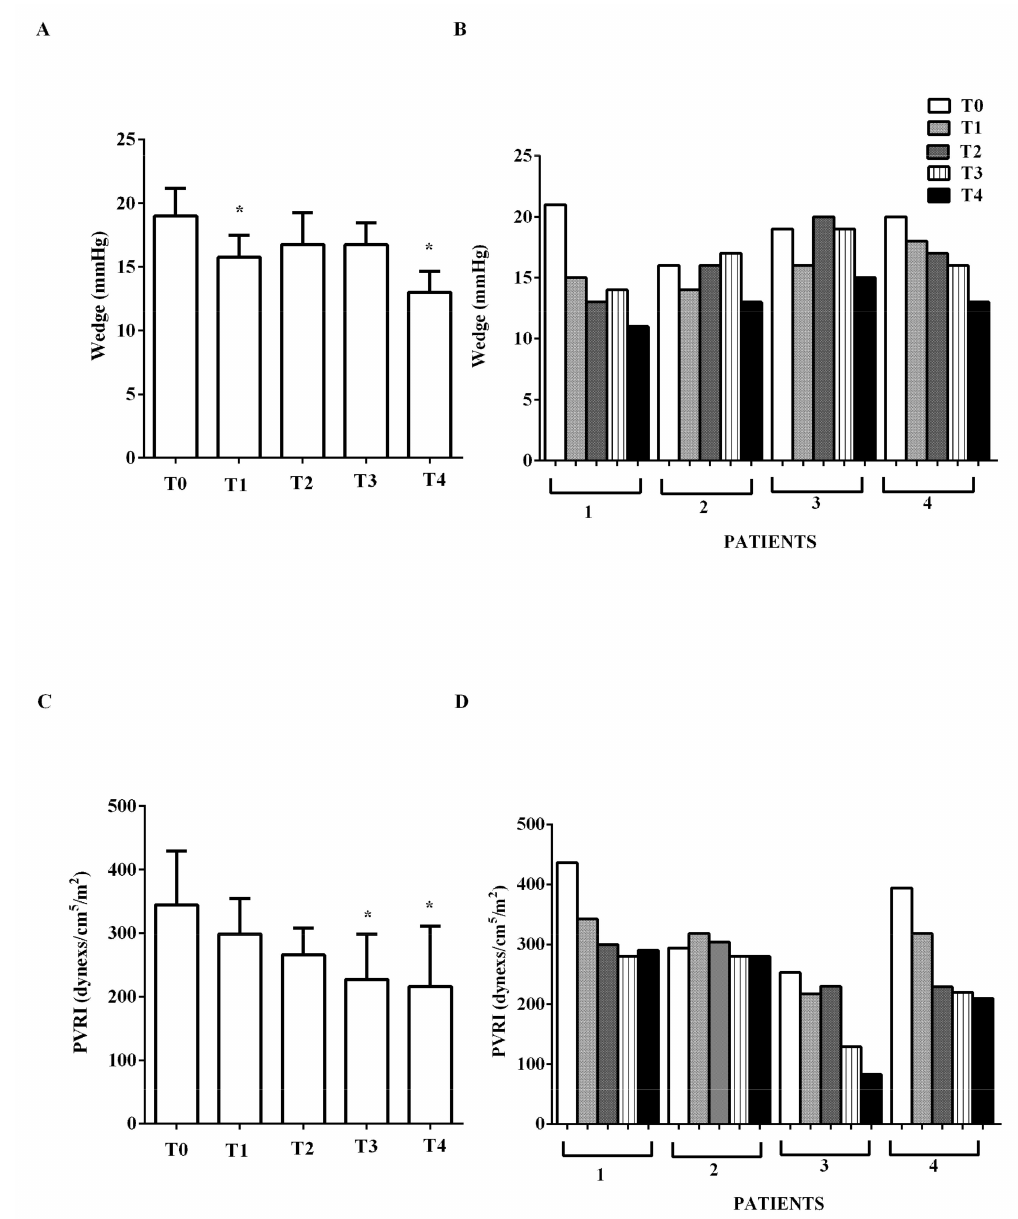
Figure 4. In ( A , B ), e ff ects of levosimendan on pulmonary capillary wedge pressure (wedge) and in ( C , D ), on pulmonary vascular resistance index (PVRI). In A and C, values are means ± SD. In B and D, columns represent single patients. * p < 0.05 vs.